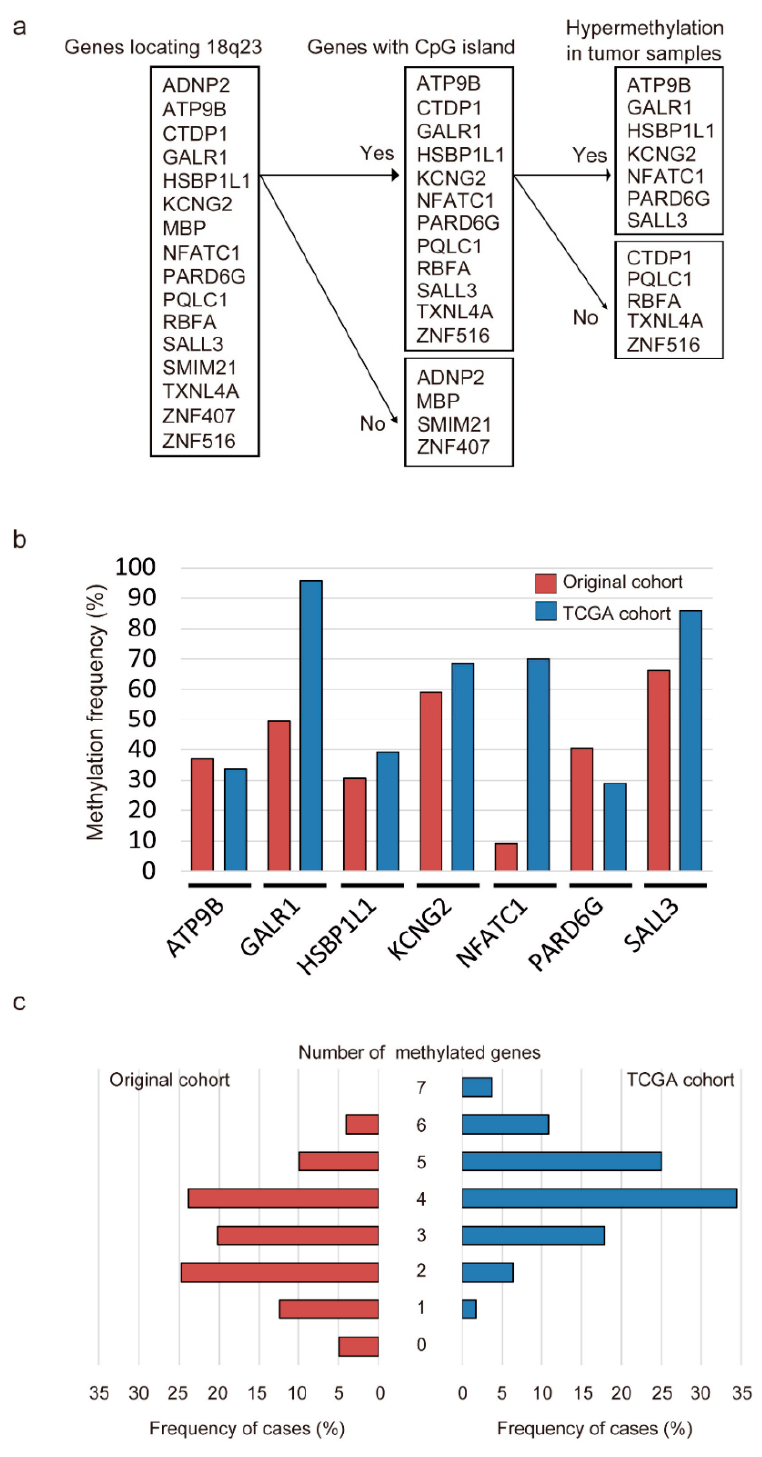
Figure 1. Methylation of genes located on 18q23 in head and neck squamous cell carcinoma (HNSCC) samples. ( a ) flow chart of the selection of candidate genes; ( b ) bar graph showing the methylation frequencies of the seven genes in the original cohort (red bars) and TCGA cohort (blue bars). ( c ) bar graph comparing the number of HNSCC cases to the number of methylated genes in the original cohort (red bars) and TCGA cohort (blue bars).